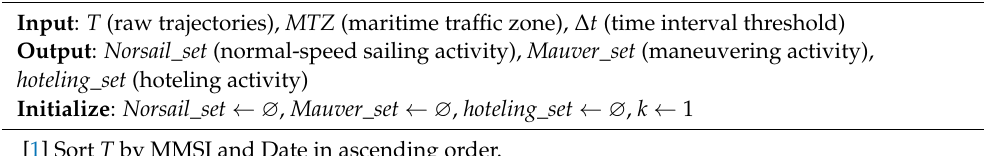
Algorithm 1 Multi-criteria Ship Motion State Recognition and Voyage Division